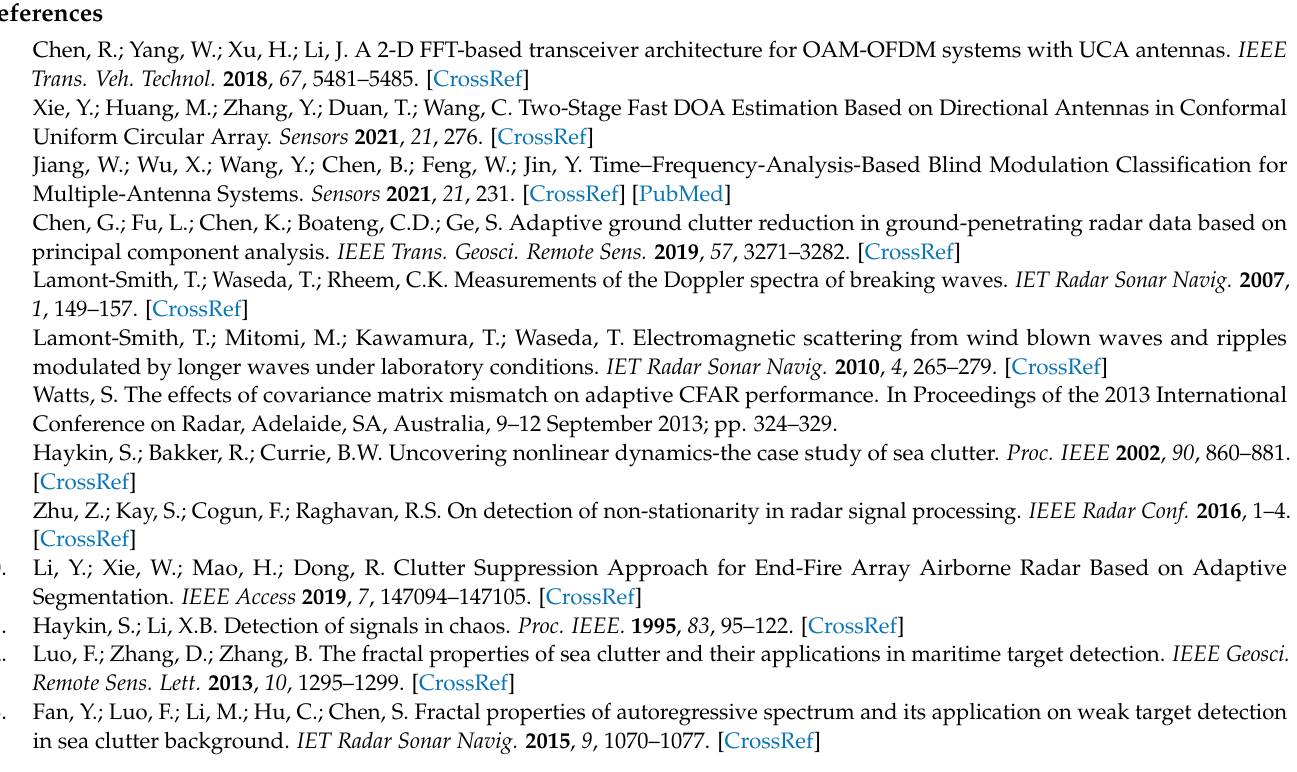
Figure A2. Recursive analysis results of range sampling signal of UCA radar ground clutter. The data comes from the UCA radar test experiment in the dry grassland scene. The scene’s clutter background is relatively clean, and the change of the ground structure in each distance unit within the irradiation range of the beam in the fifth channel is noticeable. ( a ) One dimensional sampling signal in range direction; ( b ) Phase space plan; ( c ) State distance matrix; ( d ) Recursive plot.